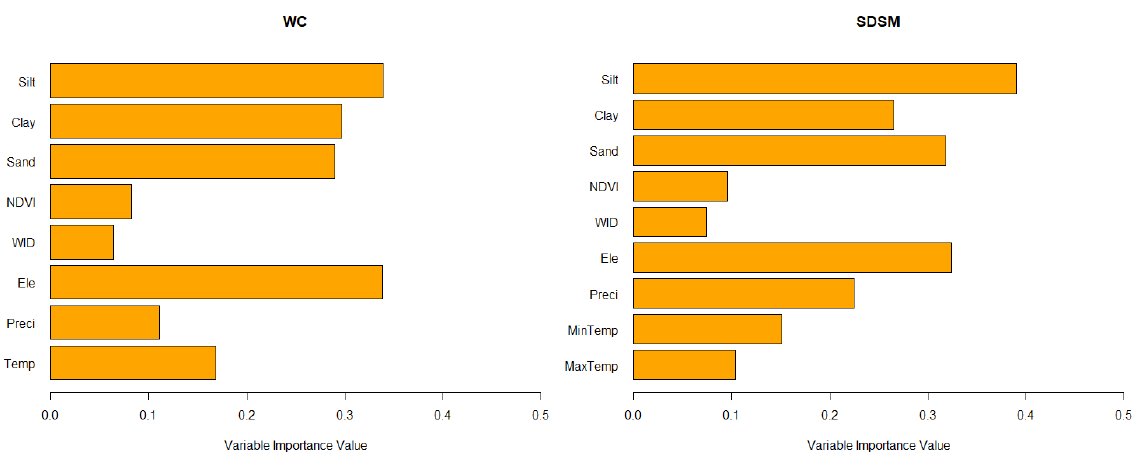
Figure 2. Mean variable importance from all WC-based and SDSM-based models (WID: Wealth Index, Ele: Elevation, Preci: Precipitation, Temp: Temperature, MaxTemp: Maximum Temperature, and MinTemp: Minimum Temperature).